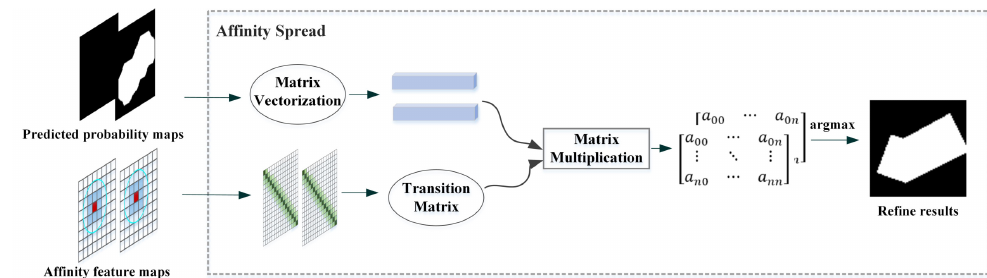
Figure 4. The process of affinity spread.